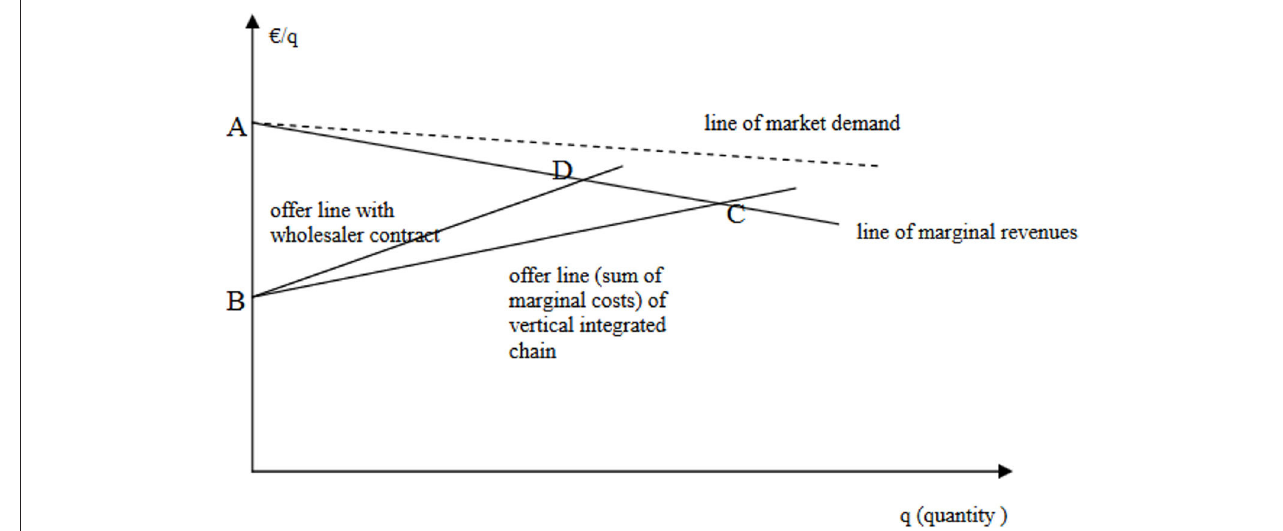
FIGURE 1 | Wholesale Contracts and Vertical Integrated